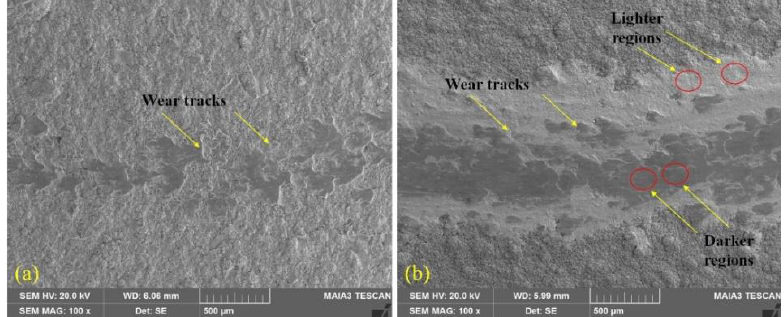
Figure 6. SEM micrographs after wear test of samples at 500 °C under 2 N load: ( a ) D-gun coating technique; ( b ) SSPS coating technique.